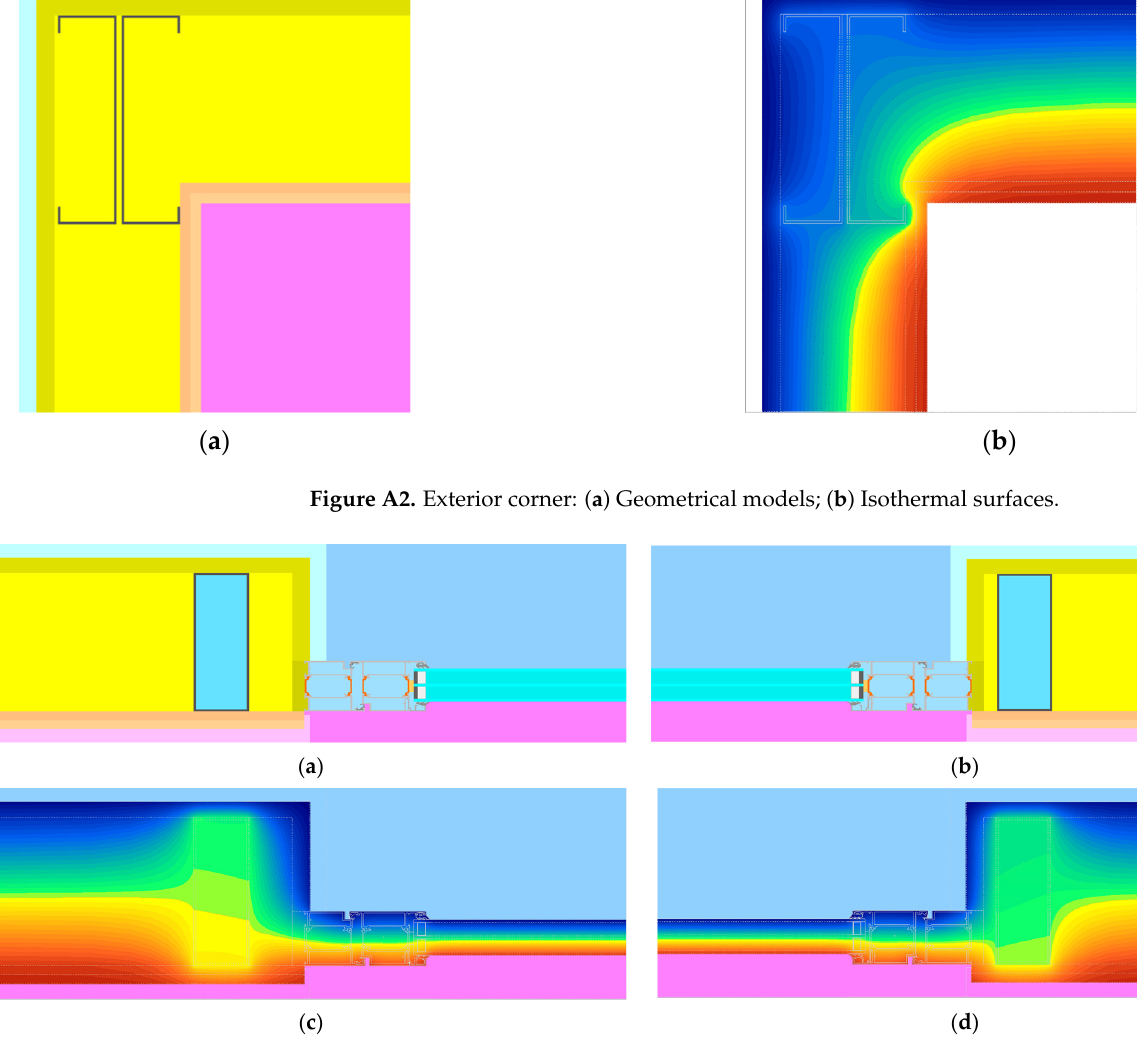
Figure A3. South exterior wall-curtain wall horizontal connection. Geometrical models: ( a ) left margin; ( b ) right margin; Isothermal surfaces: ( c ) left margin; ( d ) right margin.